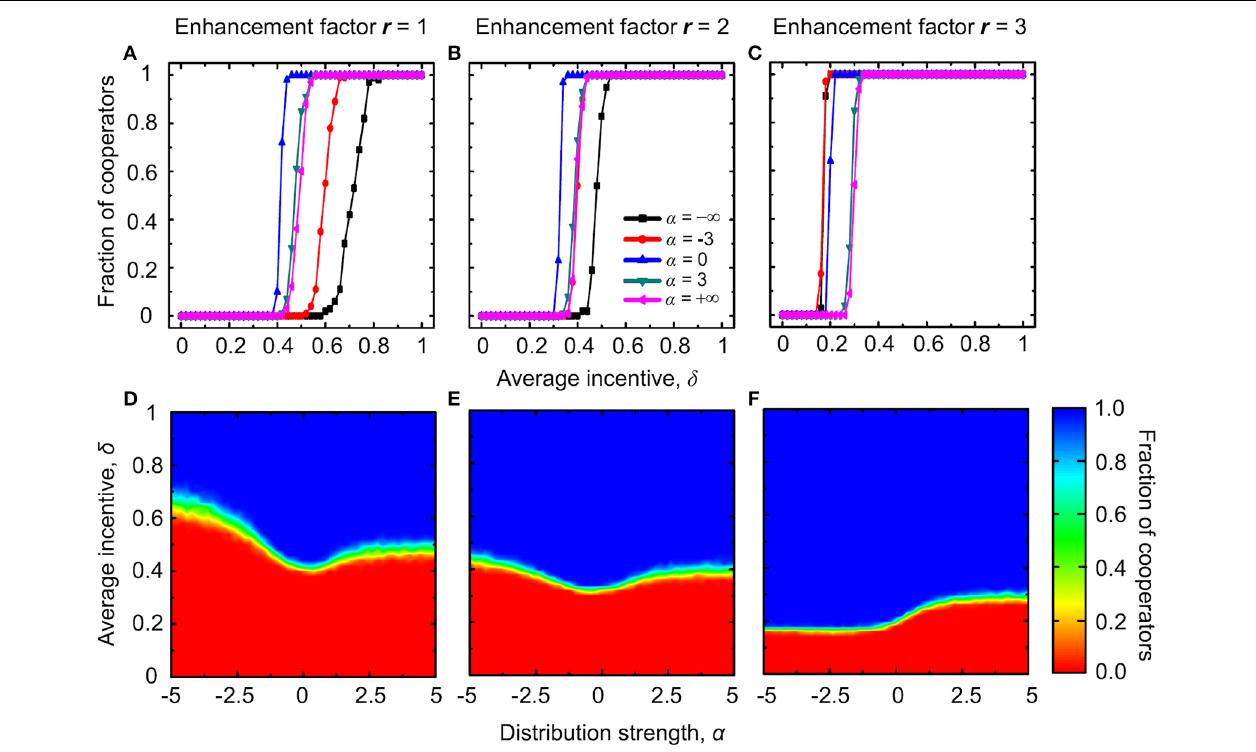
FIGURE 8 | Evolution of cooperation with institutional punishment and degree-normalized payoffs. Top row depicts the stationary fraction of cooperators as a function of the average amount of available incentives δ for different values of the distribution strength α . The